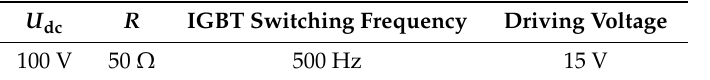
Figure 7. Process diagram of monitoring and analysis.